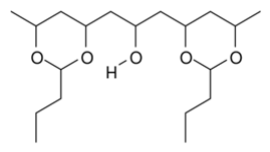
Fig. 4 Chemical composition of PVB